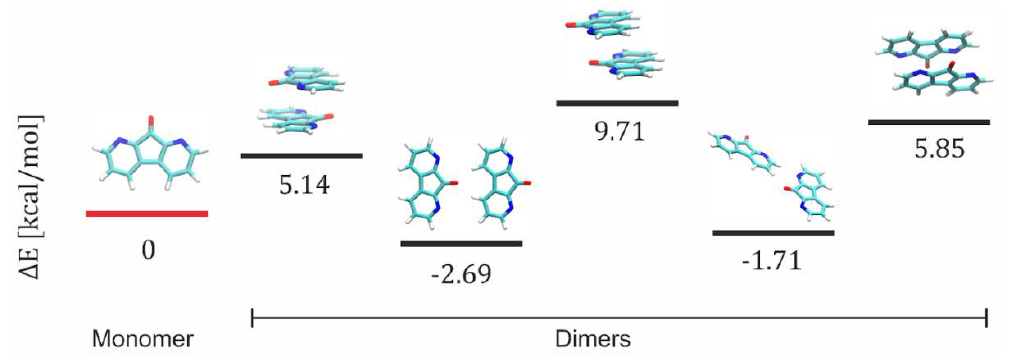
Figure 9. The energy differences between a system composed of monomers and one containing clustered molecules in the form of second aggregates (dimer).